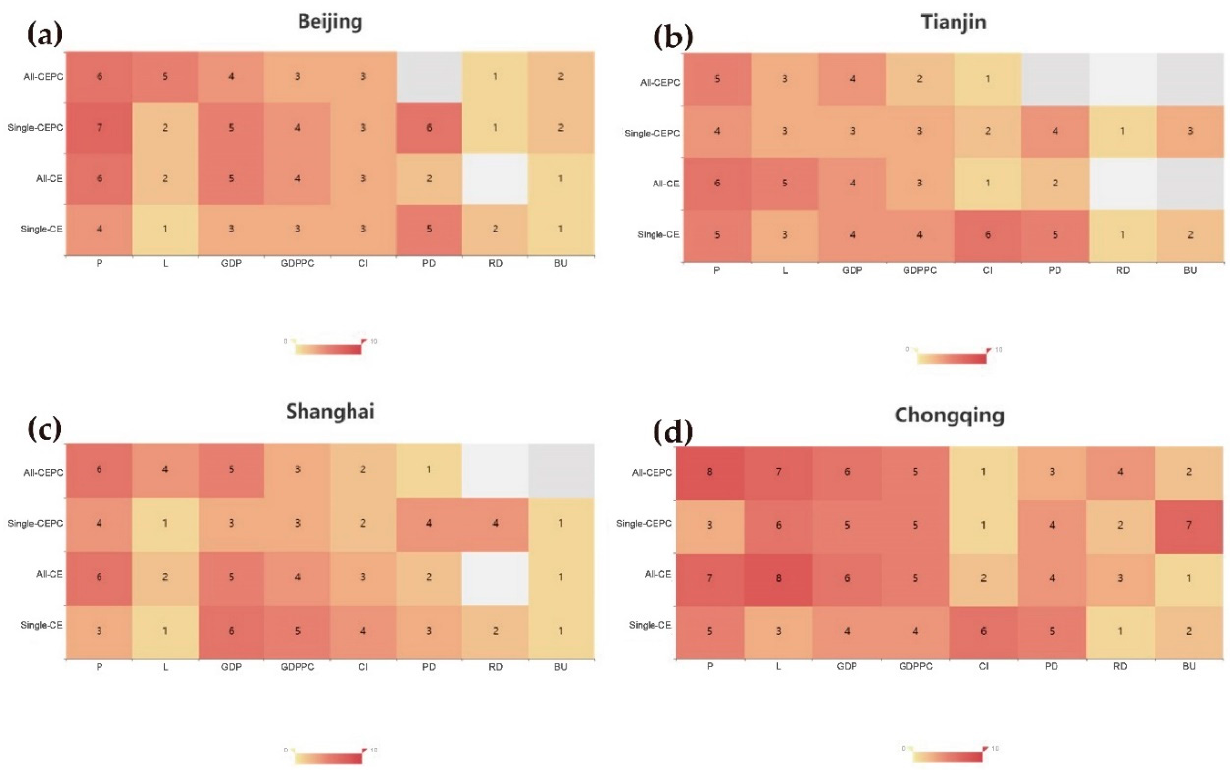
Figure 7. Comparative analysis. ( a ) Beijing; ( b ) Tianjin; ( c ) Shanghai; ( d ) Chongqing.